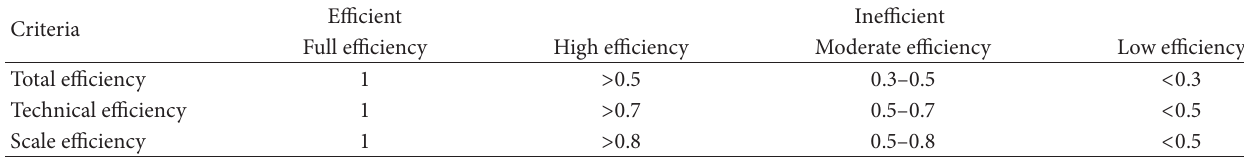
Table 5: Classification threshold values of the criteria for ecoefficiency of intensive agricultural